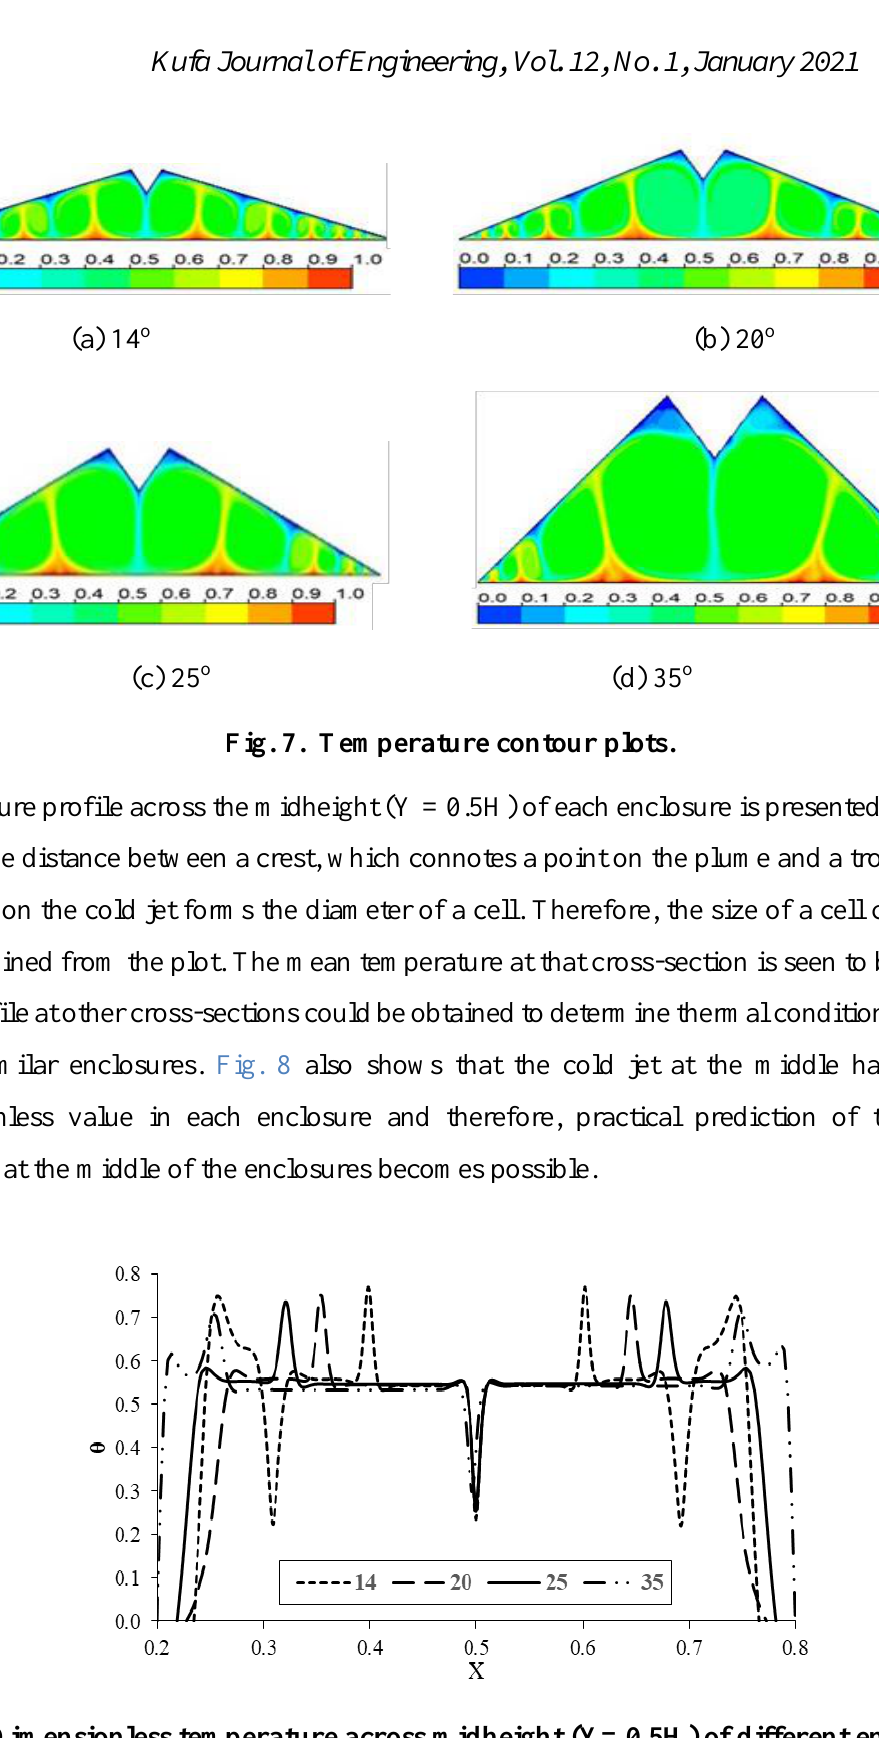
Fig. 8. Dimensionless temperature across midheight (Y= 0.5H) of different